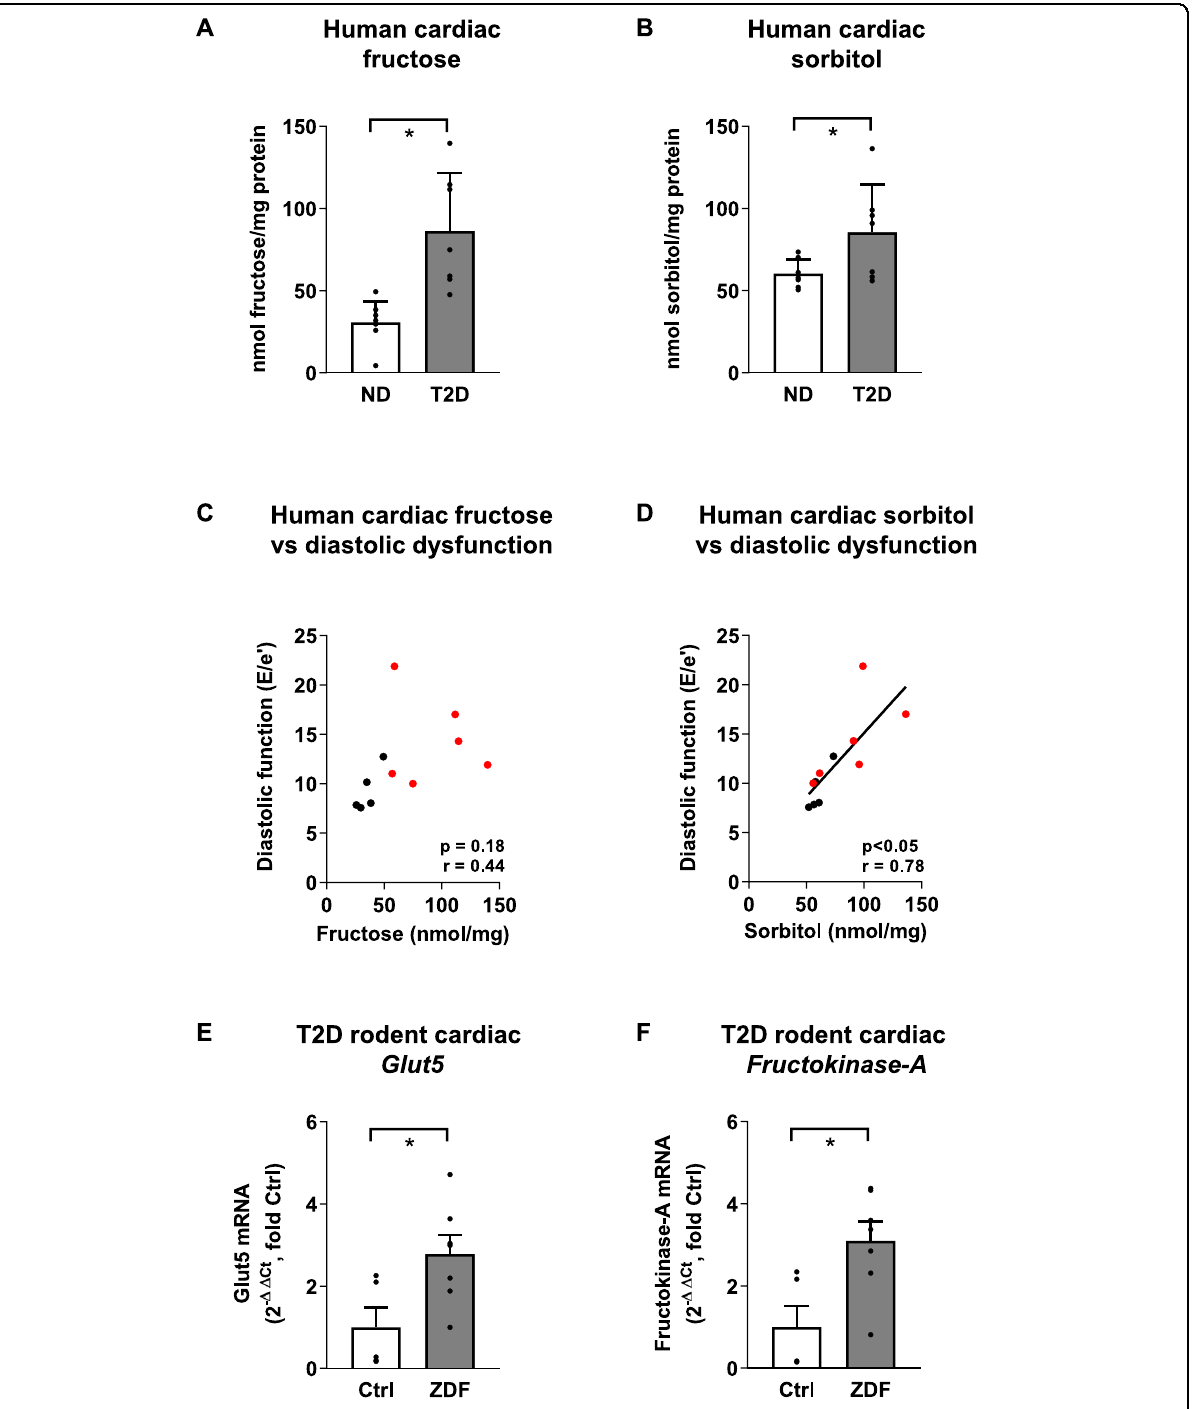
Fig. 1 Myocardial fructose metabolism in type 2 diabetes. A , B Cardiac fructose and sorbitol levels are increased in human type 2 diabetic (T2D, n = 7) patient right atrial appendage samples relative to non-diabetic (ND, n = 8) patients. Mean ± SD. C Correlation of cardiac fructose levels and diastolic dysfunction (E/e ’ ratio) in ND (black, n = 5) and T2D (red, n = 6) patients ( r , Pearson correlation coef fi cient). D A signi fi cant positive correlation is evident between cardiac sorbitol levels and diastolic dysfunction (E/e ’ ratio) for ND (black, n = 5) and diabetic (red, n = 6) patients ( r , Pearson correlation coef fi cient). E , F Glut5 and Fructokinase-A mRNA expression is increased in T2D rat hearts (Zucker diabetic fatty rats (ZDF), n = 7; Controls, n = 5). Non-parametric Mann Whitney U test A , E , F , unpaired Students t-test ( B ), * p -value < 0.05, mean ±